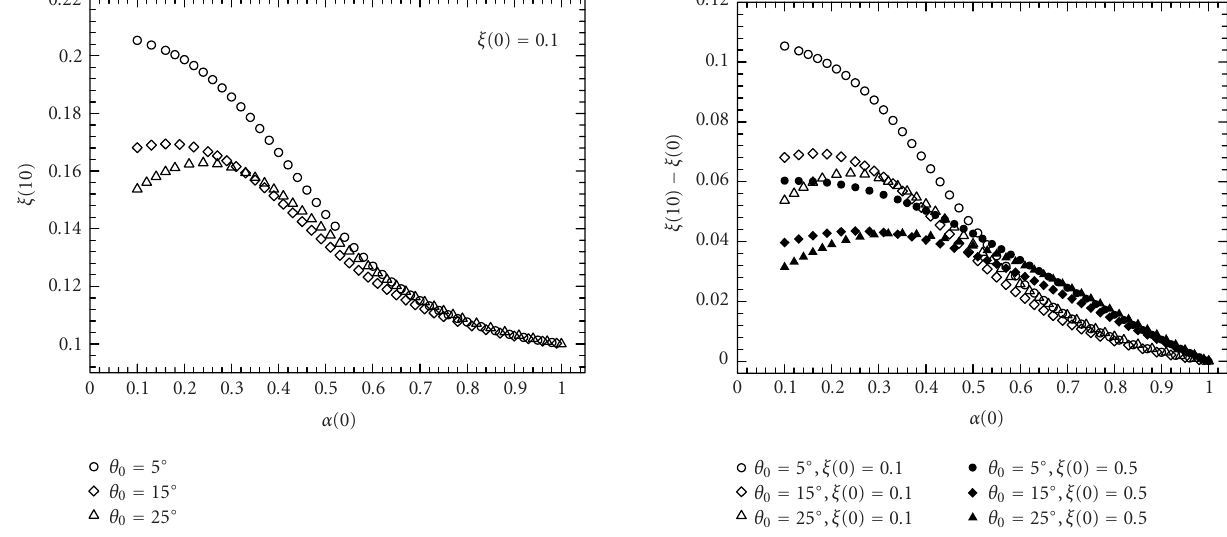
Figure 15: The level of distortion propagation versus inlet- distorted velocity coe ffi cient.